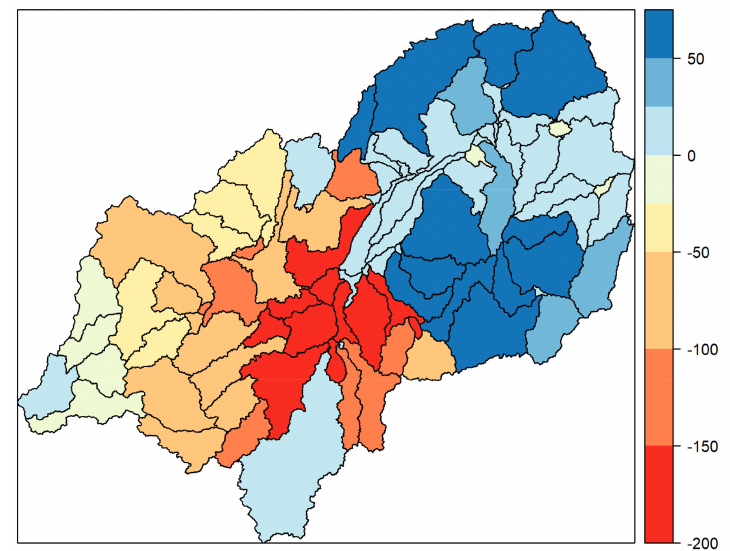
Figure 6. Spatial variations in average precipitation (mm) between 1958–1970, due to the implementation of elevation bands. Positive values correspond to increased precipitation due to the implementation of elevation bands, and vice